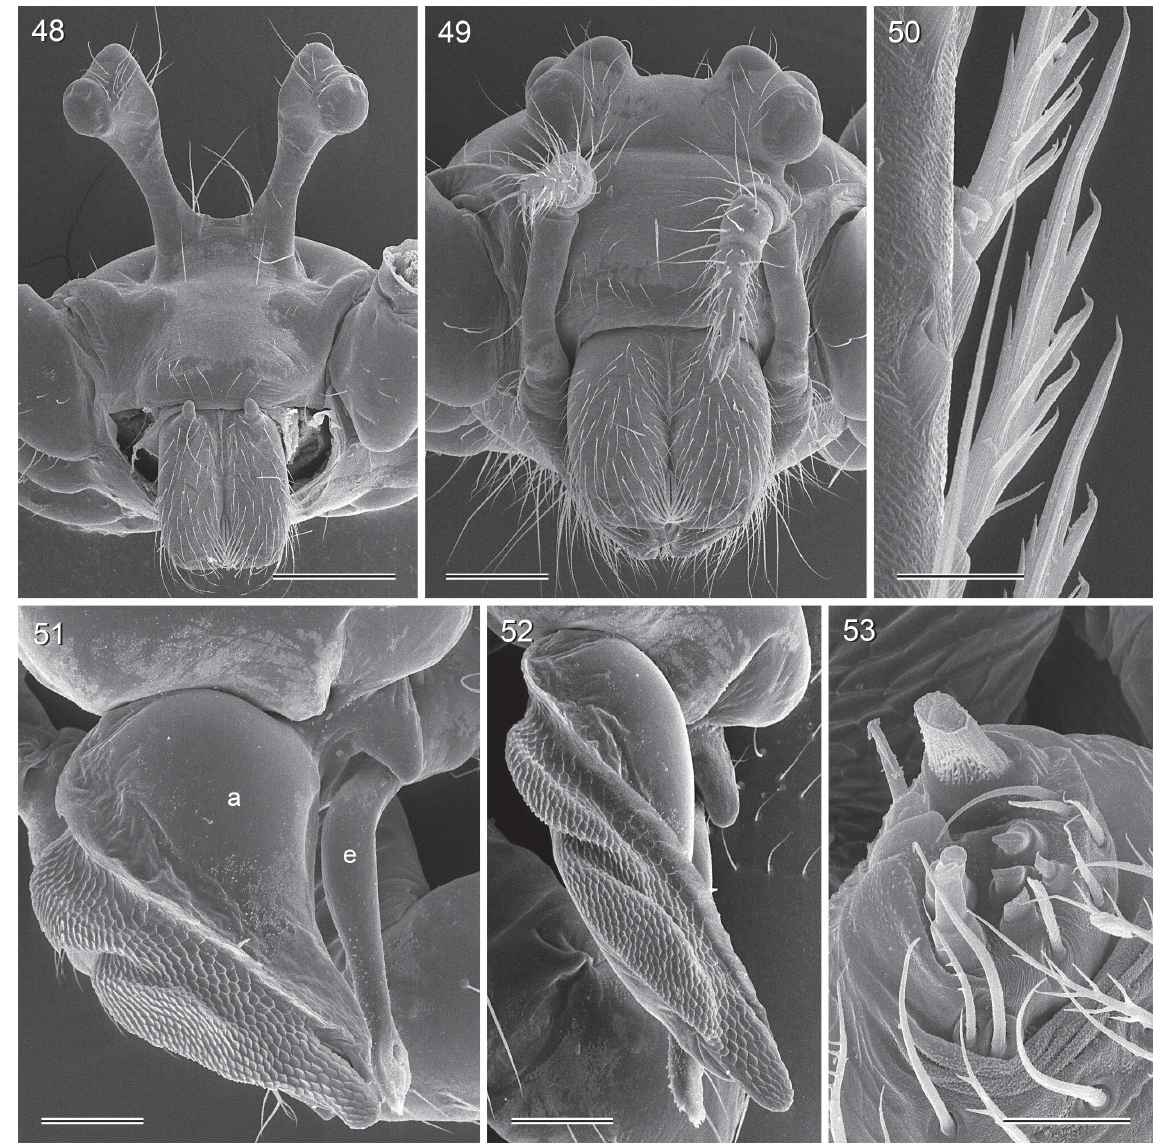
Figs 48–53. Pholcus ledang Huber, 2011, SeM micrographs (ZFMK, Ar 15704–05). 48–49 . Male and female prosomata, frontal views. 50 . Comb hairs on male tarsus 4. 51–52 . right appendix and embolus, prolateral and distal views. 53 . Female ALS. Scale bars: 48 = 300 µm; 49 = 200 µm; 50 = 10 µm; 51–52 = 100 µm; 53 = 20